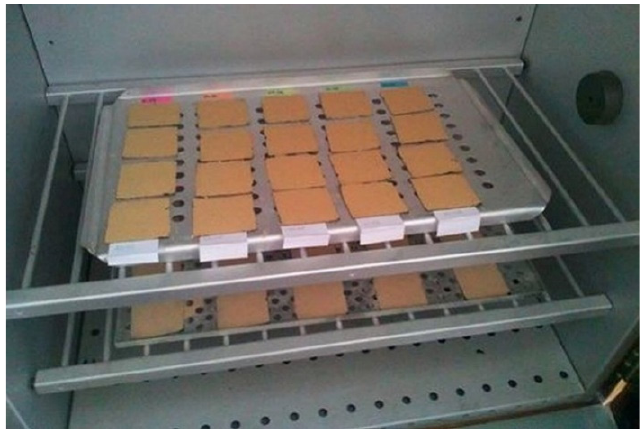
Figure 2. Specimens with a layer of biomass in a climate chamber.